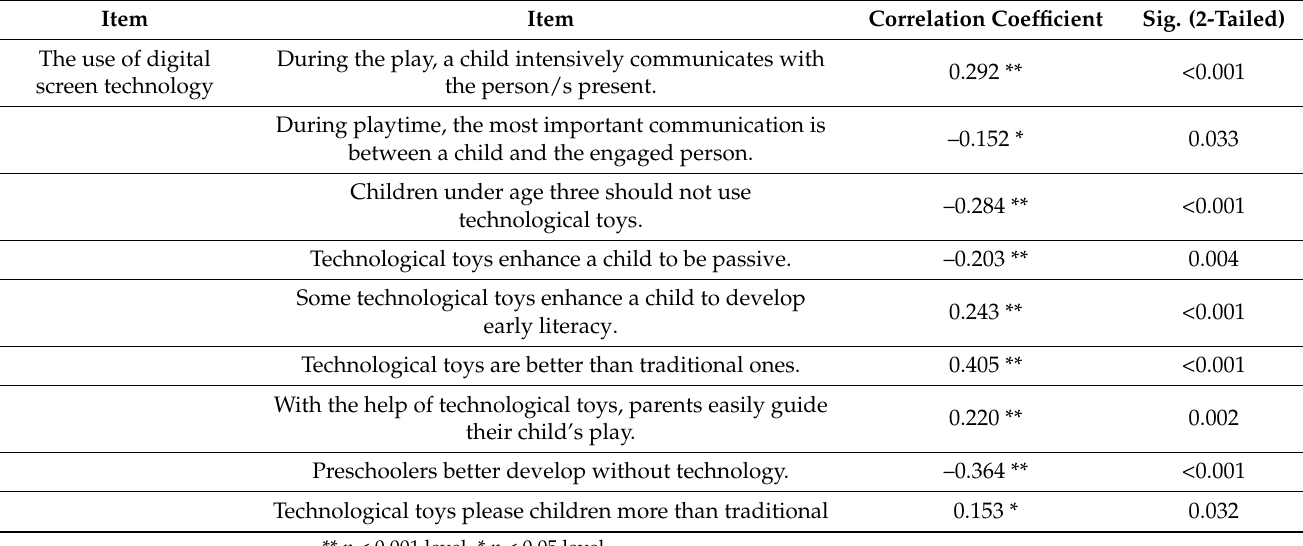
Table 2. Spearman’s correlations between the uses of digital screen technology with parents’ percep- tions of toys –significant correlations are presented. Correlation Coefficient Sig.